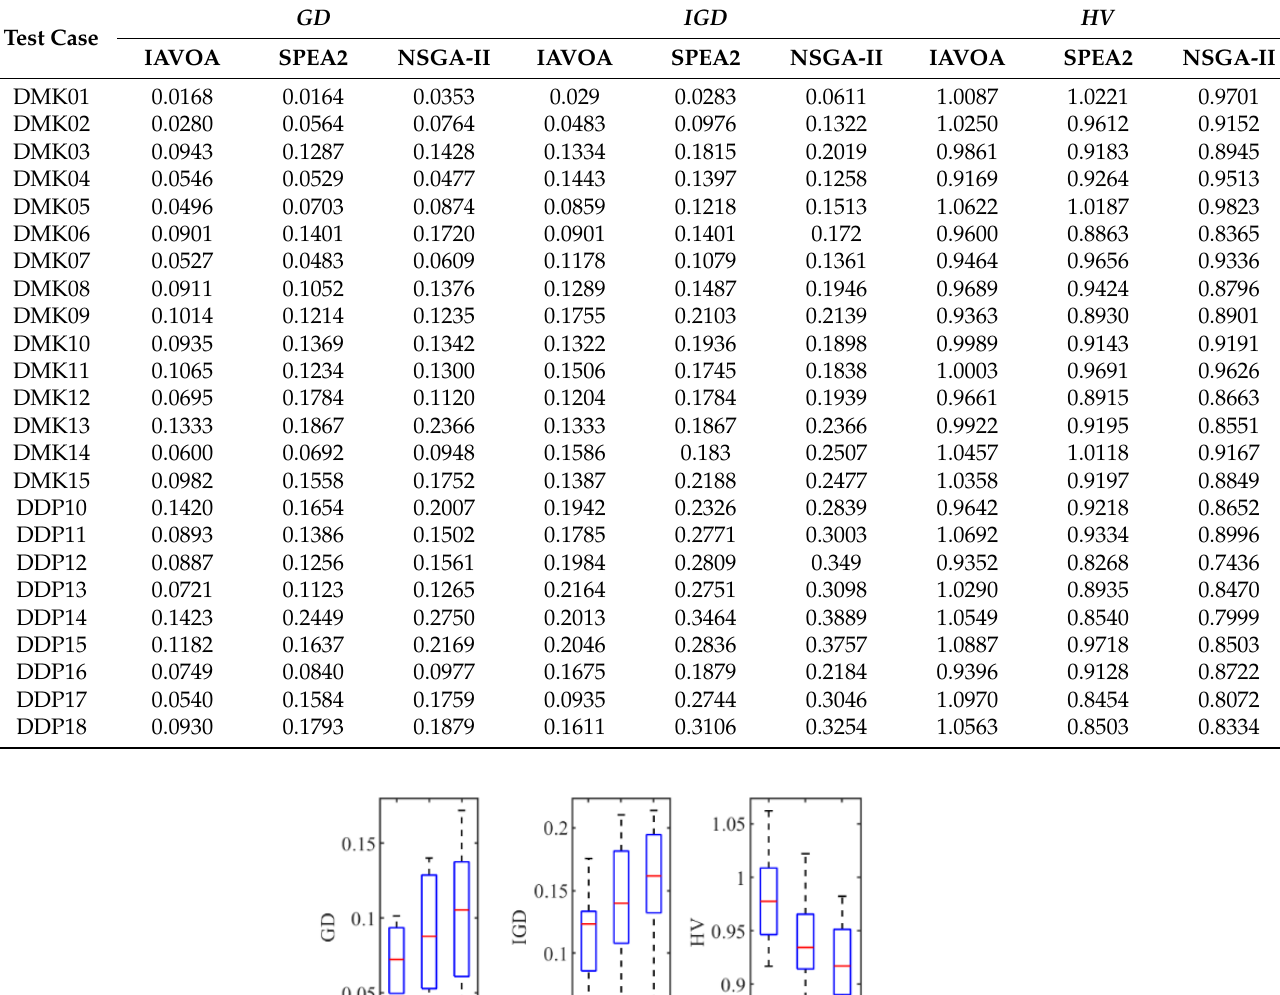
Table 7. Objective function values for the test cases solved with the three algorithms.